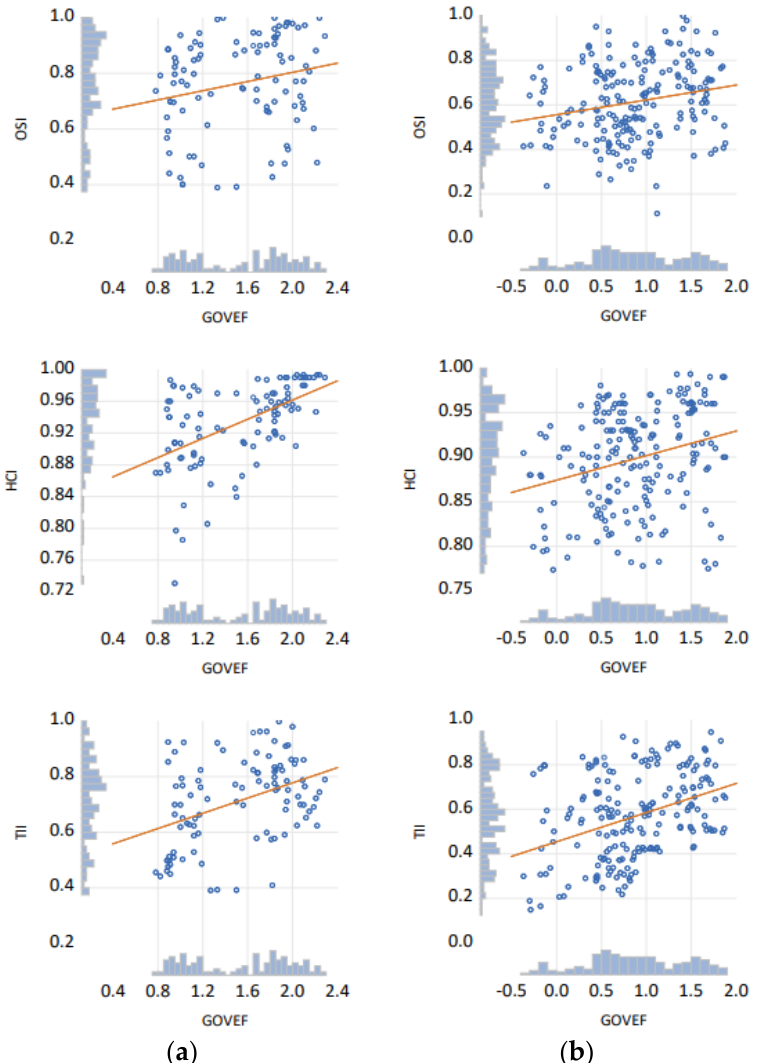
Figure 6. Histogram and dispersion of intercepts: ( a ) Cluster A and ( b ) Cluster B. Table 4. LLC unit root test